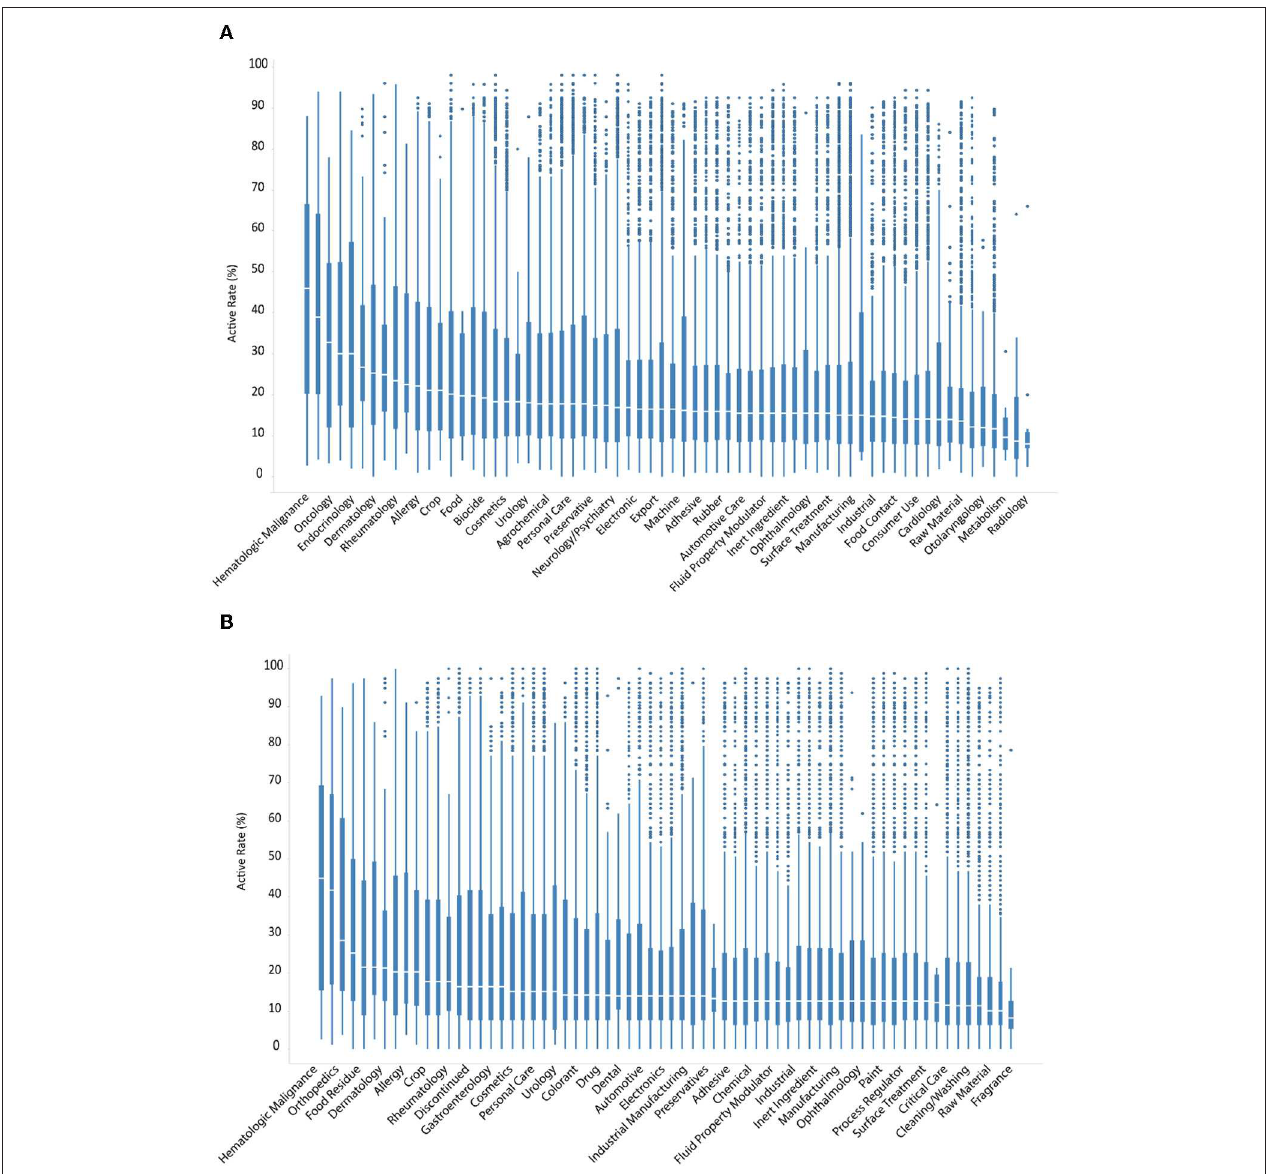
FIGURE 4 | Hit rates of drugs and ENVCs by use category when screened against (A) all assays, or (B) only viability